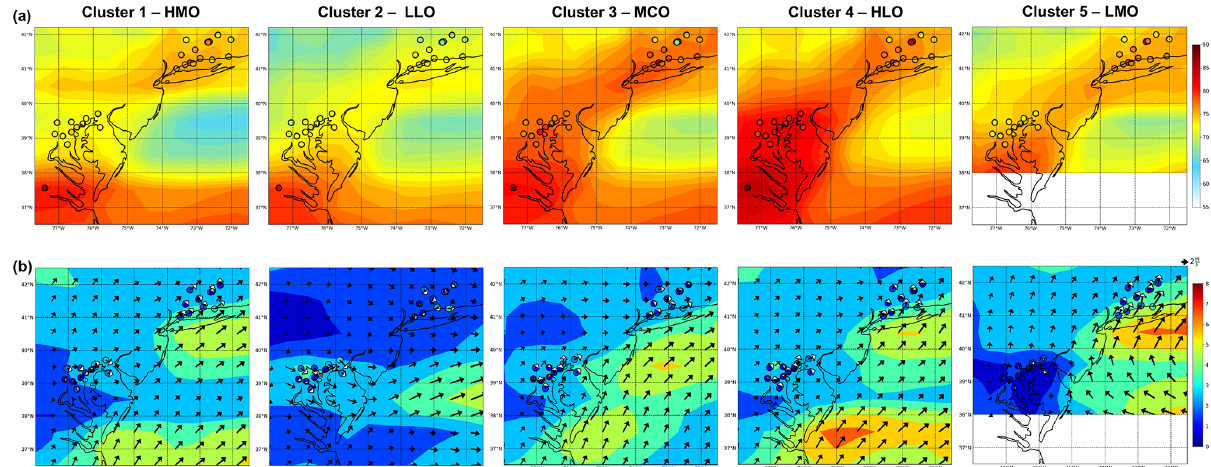
Figure 5. Cluster-averaged meteorological surface AQS station observations and GEOS-Chem model results. (a) Surface temperature ob- servations represented as the circular markers and simulated surface temperatures represented as the spatial contour (top row). (b) Surface wind speed and direction observations represented as circular markers and white arrows and simulated wind speed and direction represented as spatial contour and black arrows (bottom